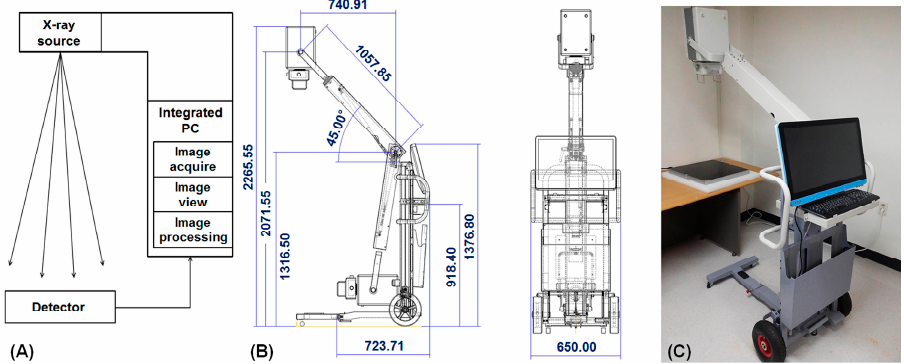
Figure 1. A simple diagram of portable digital radiography (PDR) ( A ), the detailed drawing of PDR structure ( B ) and developed PDR system ( C ).